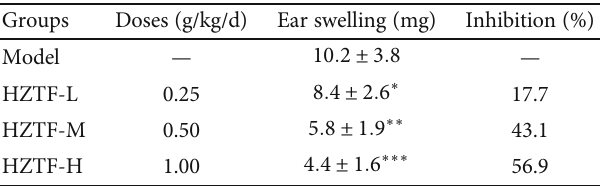
Table 6: E ff ects of HZTF on writhing response induced by antimony potassium tartrate in mice ( n = 10